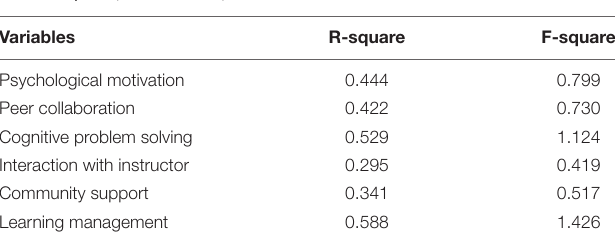
TABLE 5 | R-square and